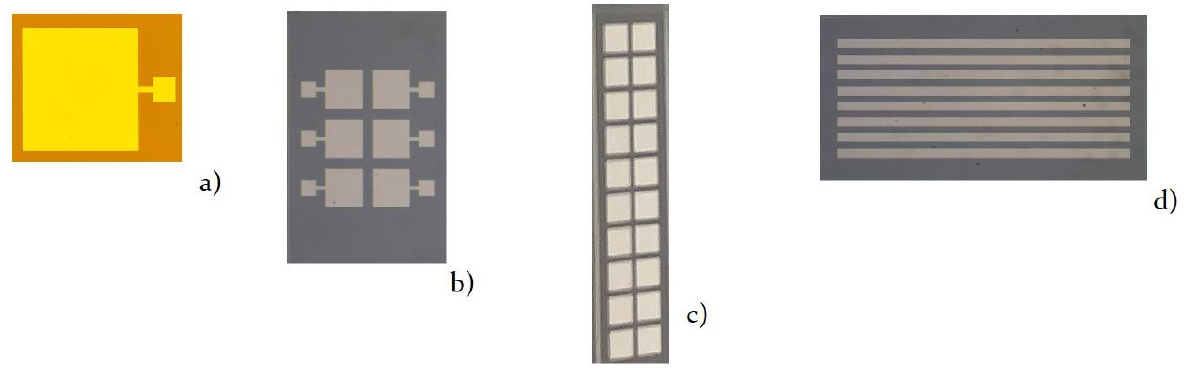
Figure 5. Vertical diode configurations: ( a ) single diode of 1.25 × 1.25 mm 2 , ( b ) 2 × 3 diode array, ( c ) 2 × 10 diode array, and ( d ) 8-strip device.